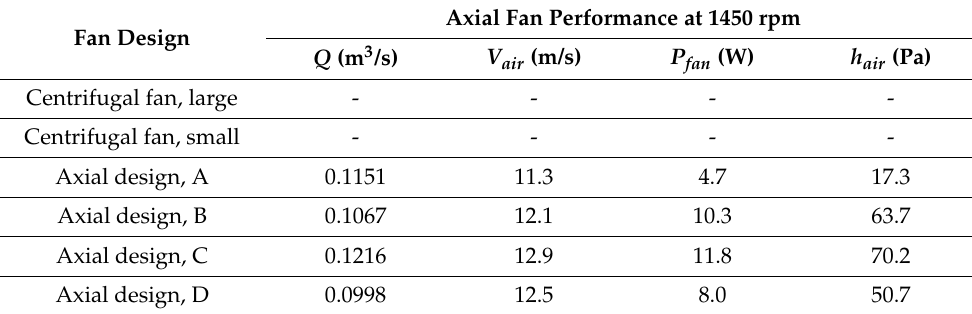
Table 2. Results of simulations for four diverse designs of axial fans [30].